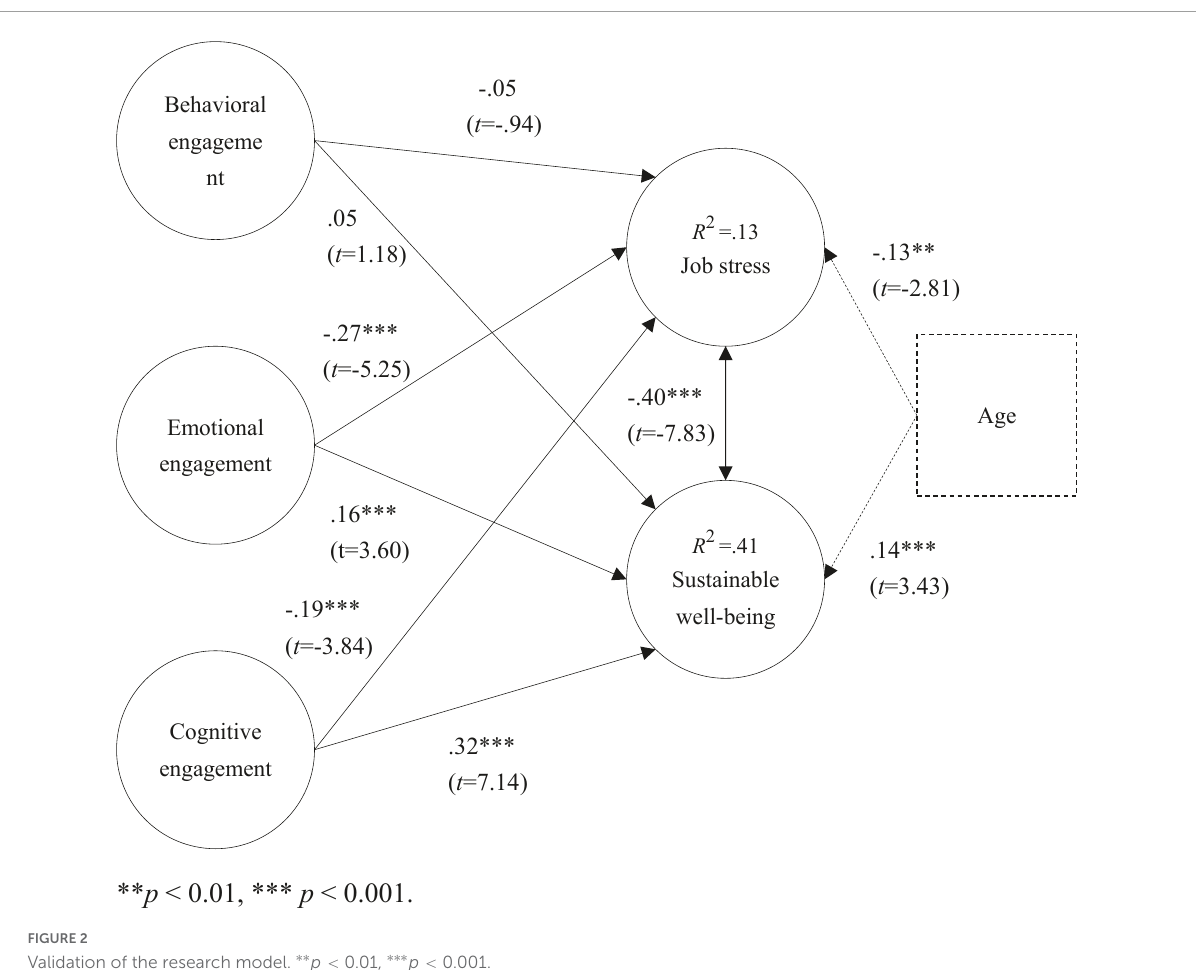
FIGURE2 Validation of the research model. ∗∗ p < 0.01, ∗∗∗ p <